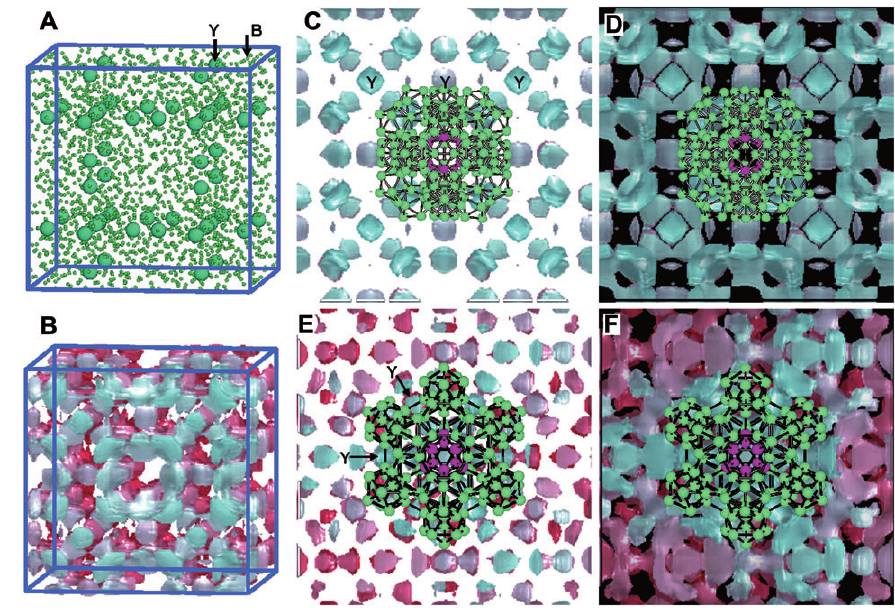
Figure 15 (A) Perspective view of YB dimensional phases and amplitudes. Projected images of three-dimensional image along (C,D) 100 and (E,F) 111 of YB